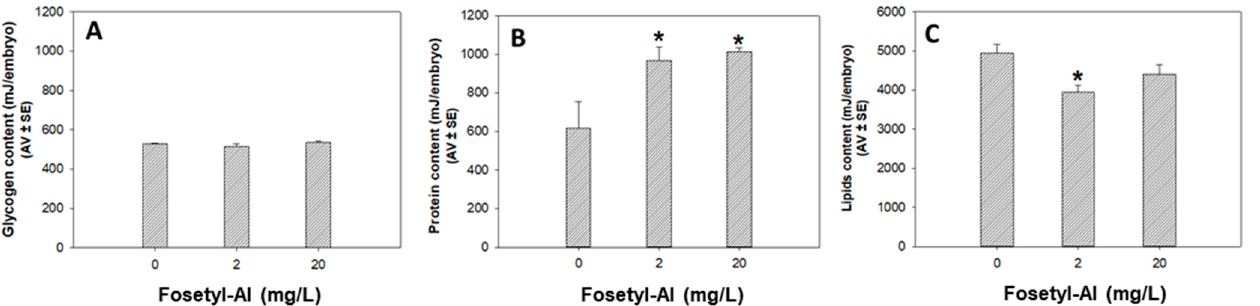
Figure 3. Effects of 96 h of exposure to fosetyl-Al on zebrafish larvae for carbohydrates’ ( A ); proteins’ ( B ); and lipids’ ( C ) contents. Data are expressed as average value (AV) ± standard error (SE). * Significant differences to control ( p < 0.05).